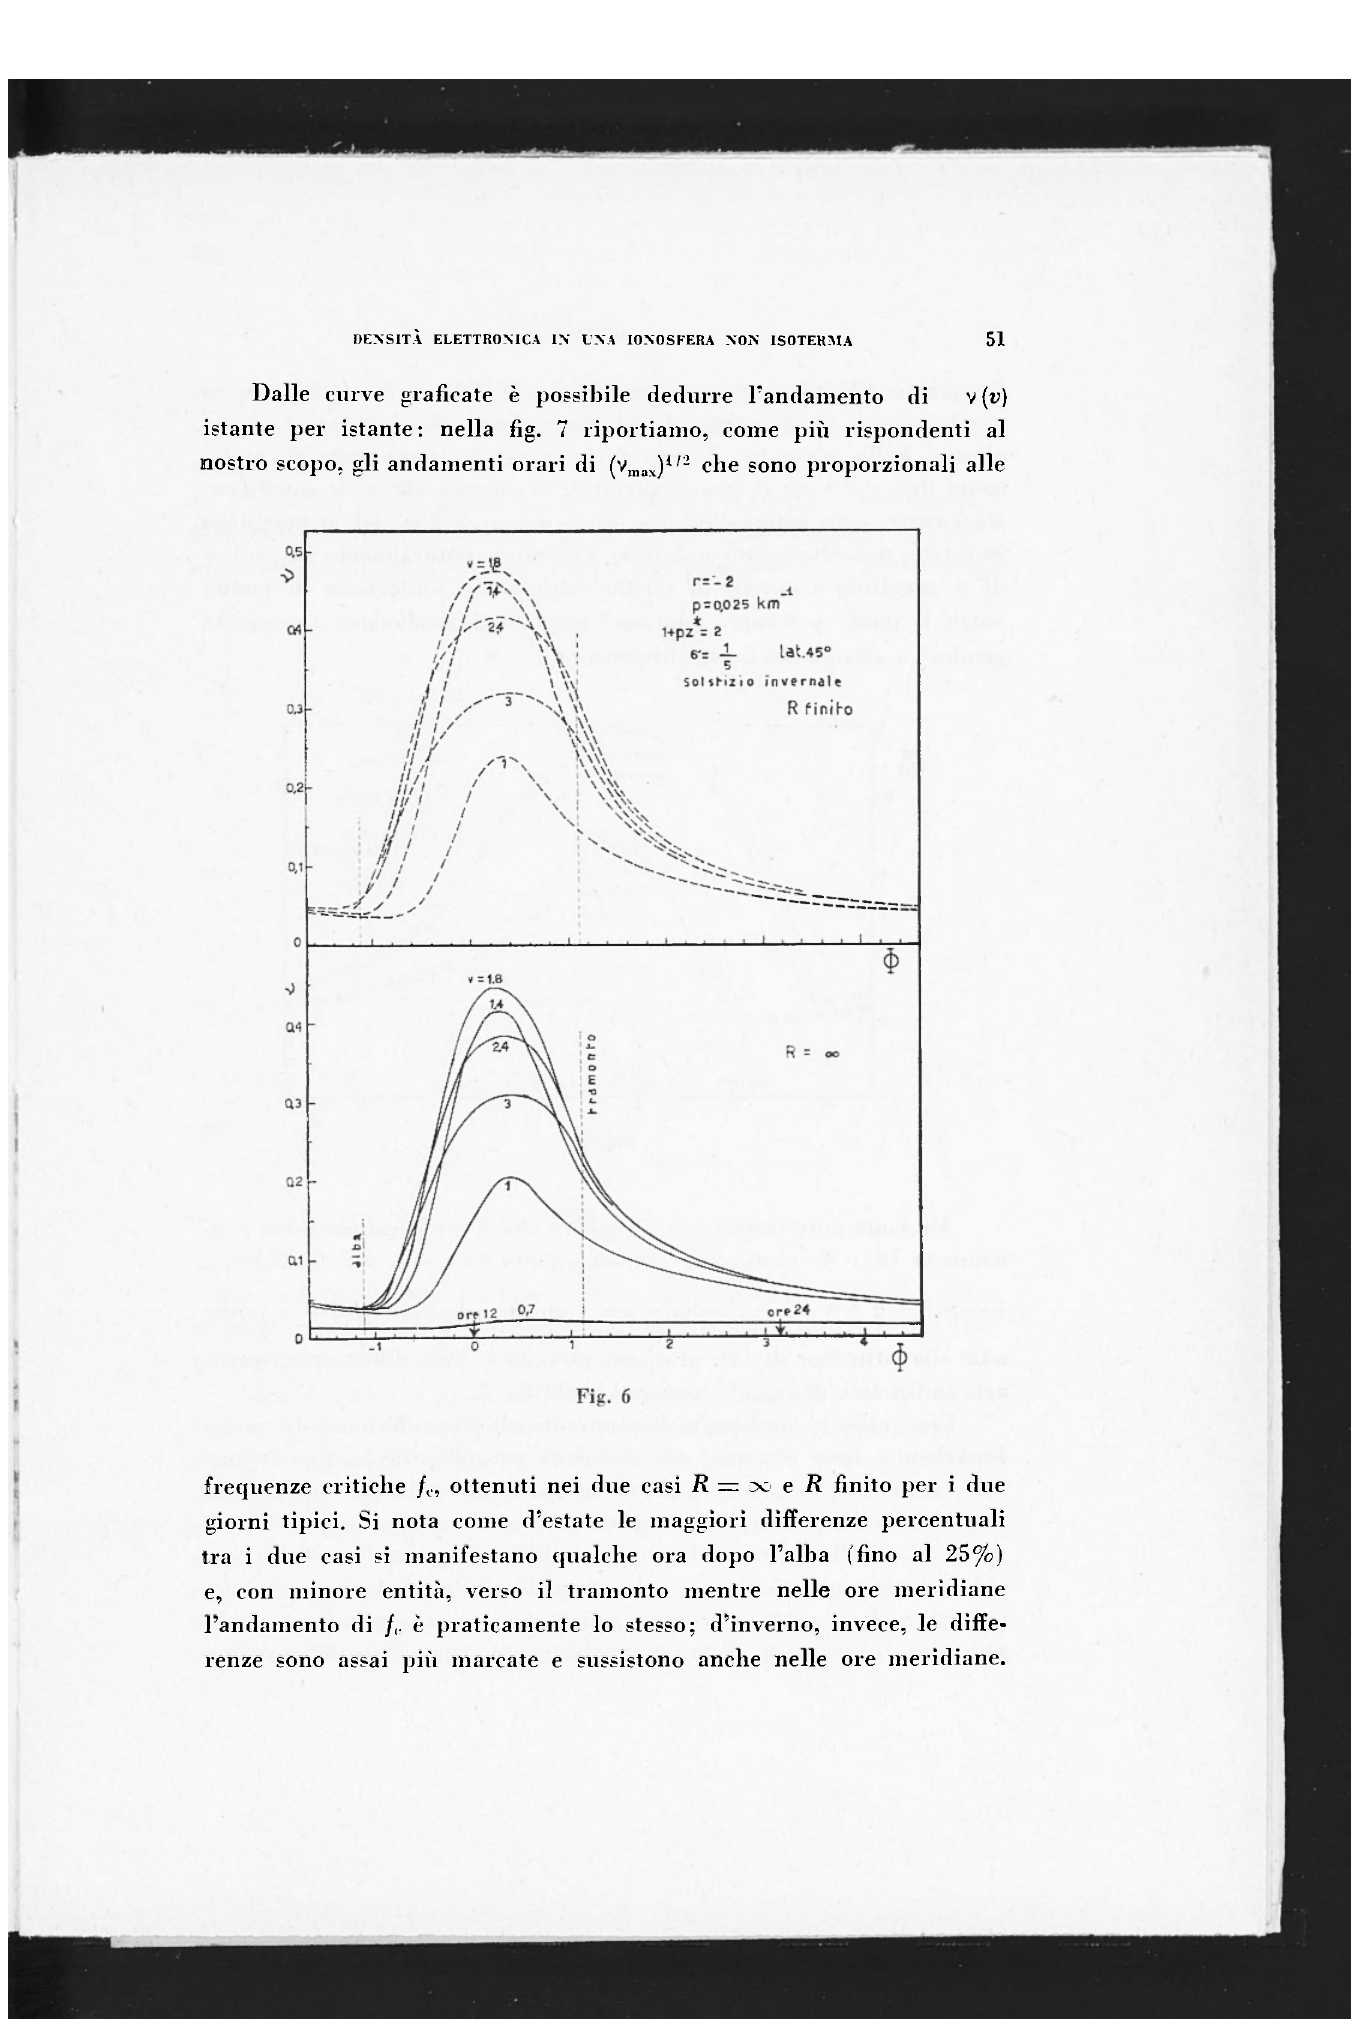
Dalle curve graficate è possibile dedurre l'andamento di v(i>) istante per istante : nella fig. 7 riportiamo, come più rispondenti al nostro scopo, gli andamenti orari di (v max ) 1 ' 2 che sono proporzionali alle